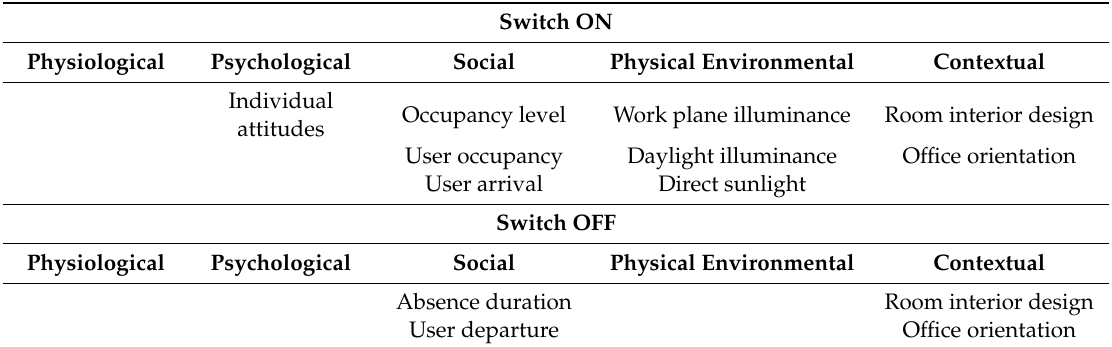
Table 2. Driving forces for energy-related behaviour with respect to lighting. Switch